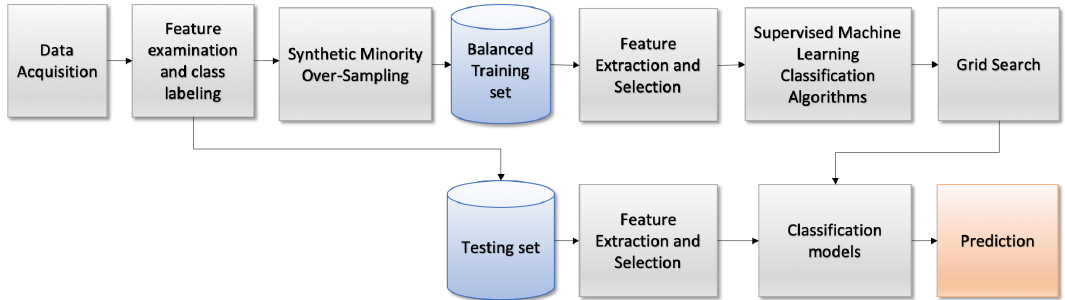
Figure 1. Workflow of proposed